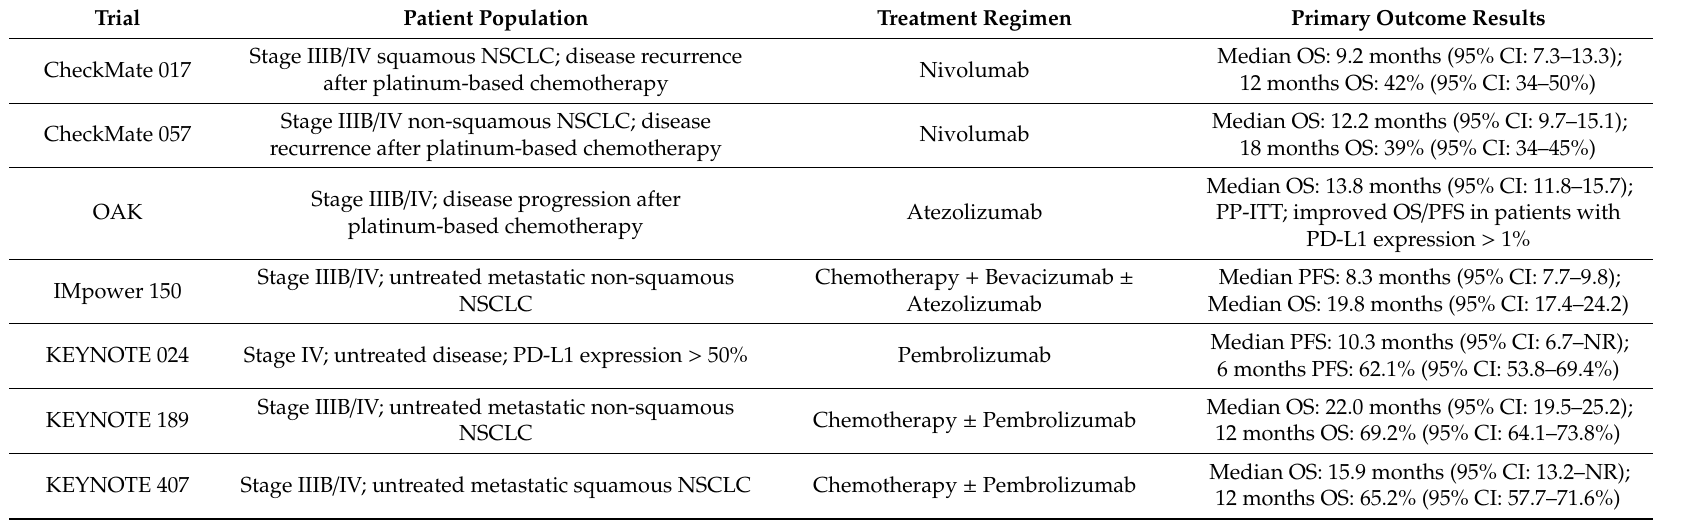
Table 1. Trials of ICIs for advanced stage